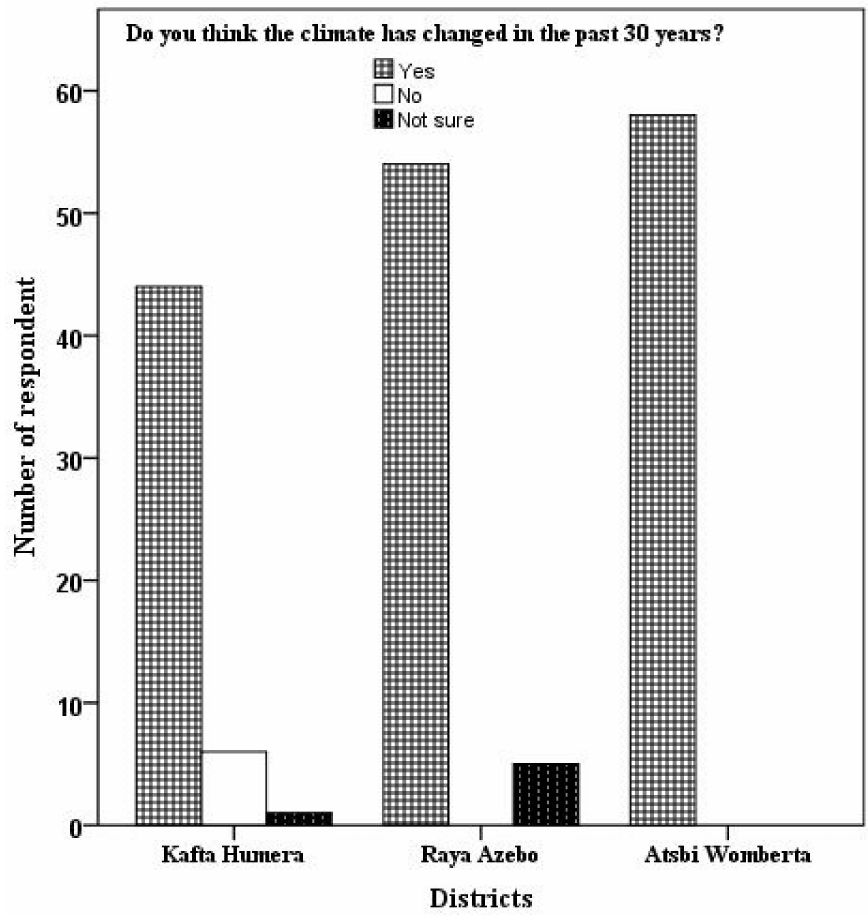
Figure 2. Household perceptions of climate change in Tigray Region, Ethiopia. Table 3. Most-perceived climate change indicators by the communities in three districts of Tigray Region,